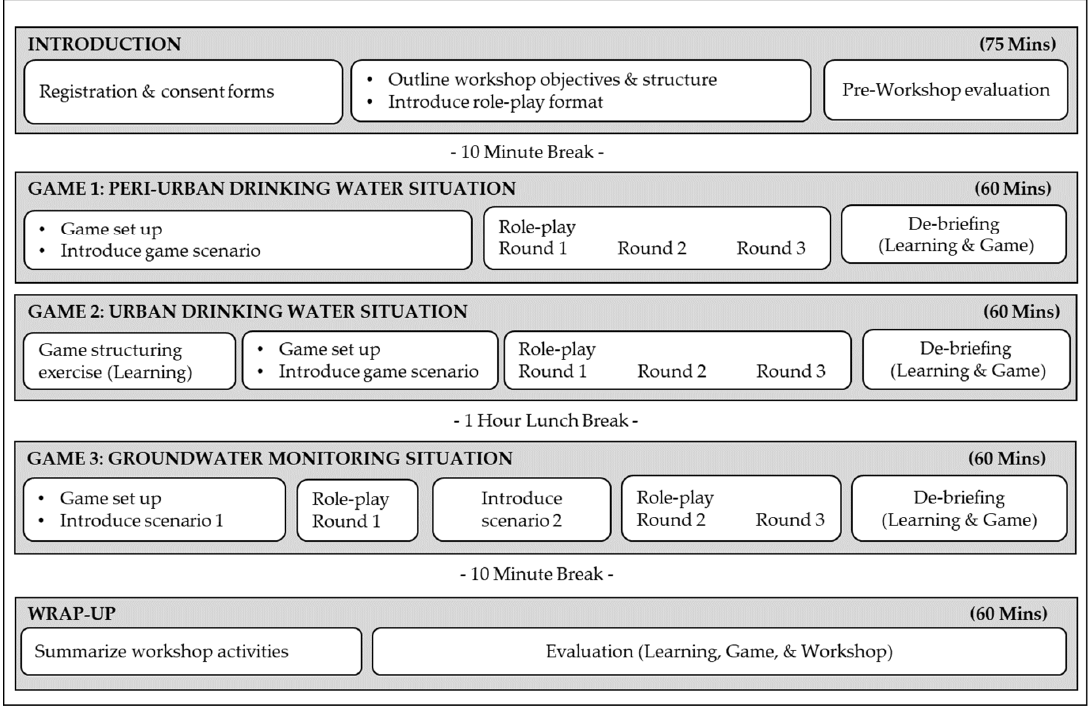
Figure 2. Overview of workshop structure.